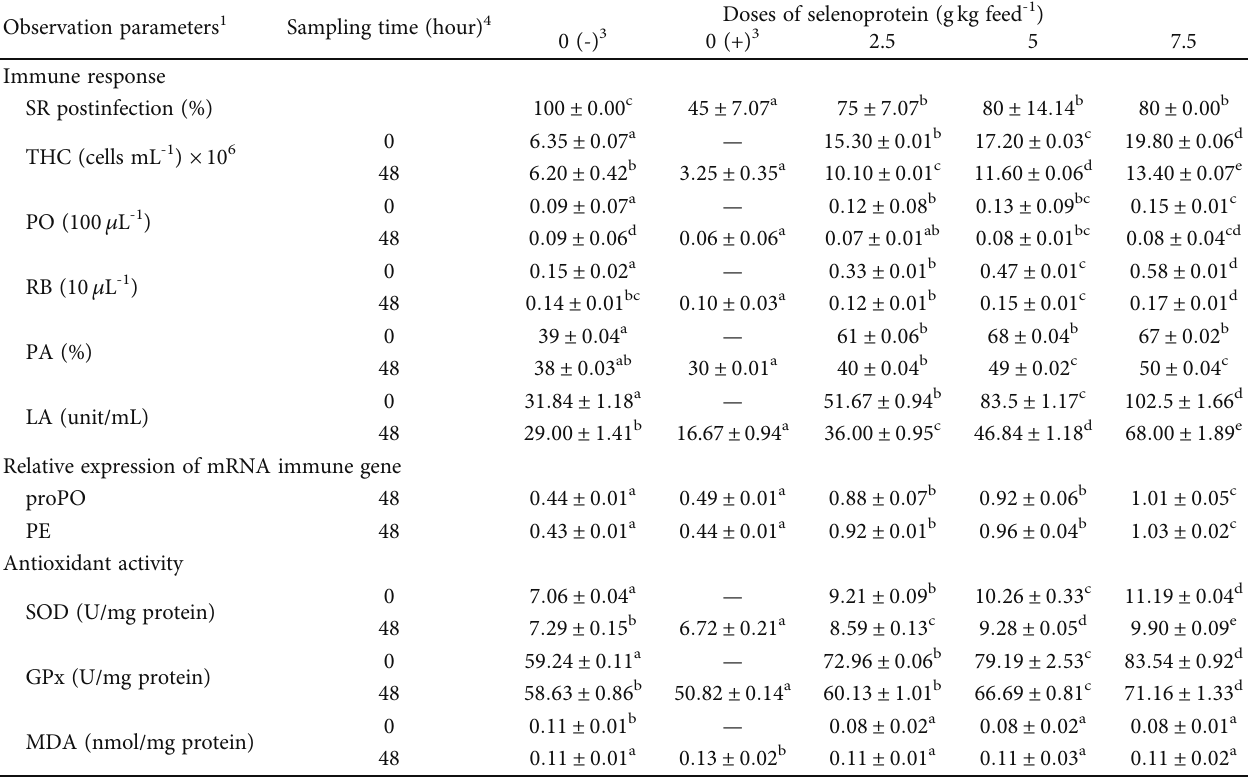
Table 5: Immune response, immune gene expression, and antioxidant activity of whiteleg shrimp after feeding treatment and infection with V . parahaemolyticus and resistance of shrimp after